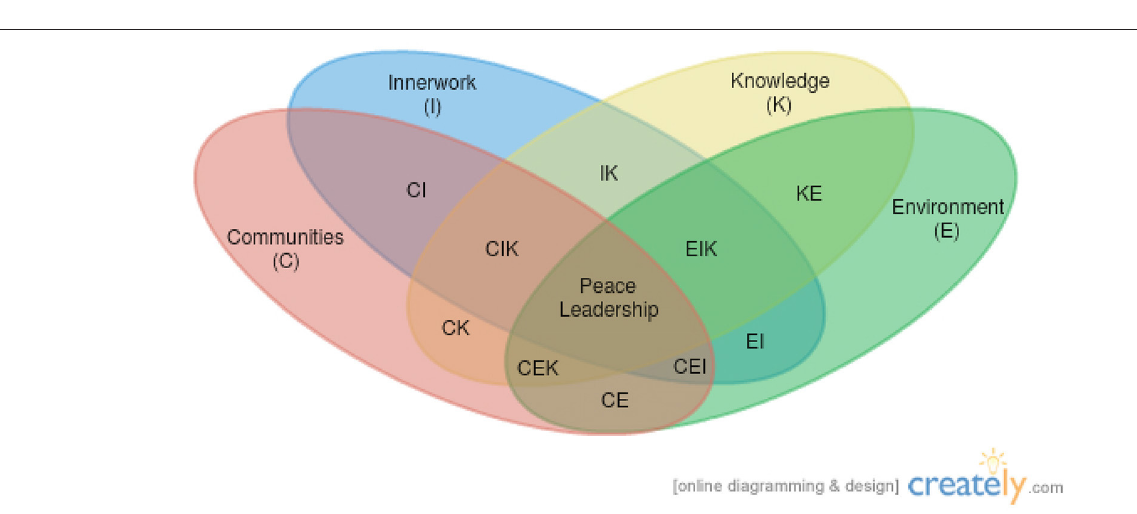
FIGURE 1 | Elements of the Integral Perspective of Peace Leadership.